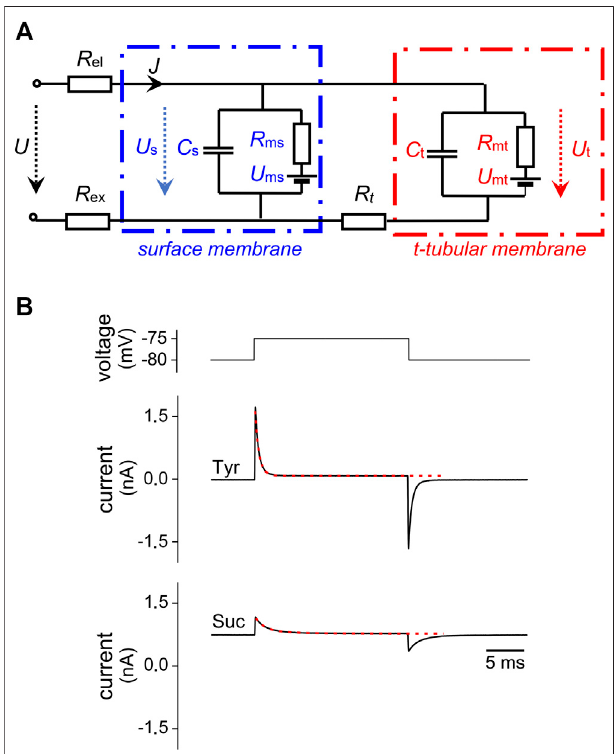
FIGURE 1 | Principle of the new method. (A) Scheme of the electrical equivalent circuit of cardiomyocyte; R el — microelectrode resistance; R ex — extracellular resistance; C s , R ms , U ms , and C t , R mt , U mt — membrane capacitance, membrane resistance, reversal voltage of the surface and t-tubular membranes, respectively; R t — resistance of t-tubular lumen. The membraneresistancescanbe considered constantinthesubthreshold range of membrane voltage. U , U s , and U t — the imposed voltage, surface membrane voltage, and t-tubular membrane voltage, respectively. J — the membrane current. (B) The imposed impulse of membrane voltage (upper panel) and representative current traces in the Tyrode (Tyr) and sucrose (Suc) solution including mono- and bi-exponential fi ts (red lines), respectively (middle and bottom